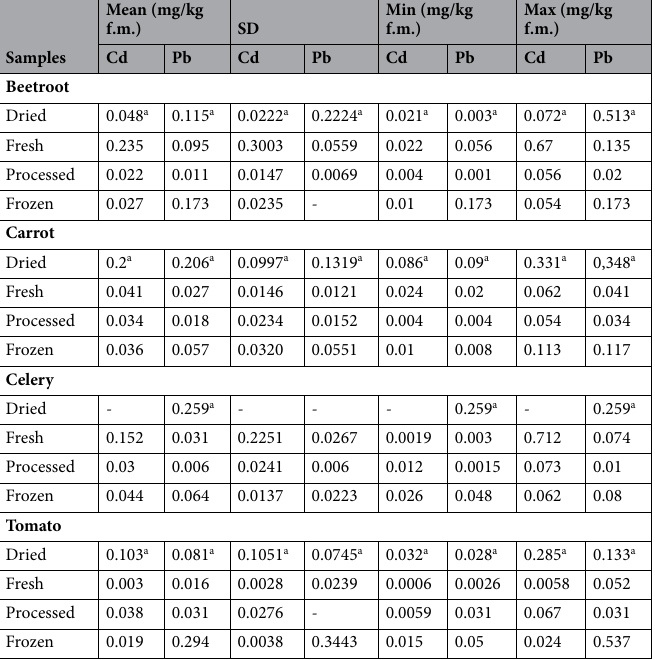
Table 7. The mean value, standard deviation, minimum and maximum values of Cd and Pb concentrations in particular types of vegetable samples. a (mg/kg